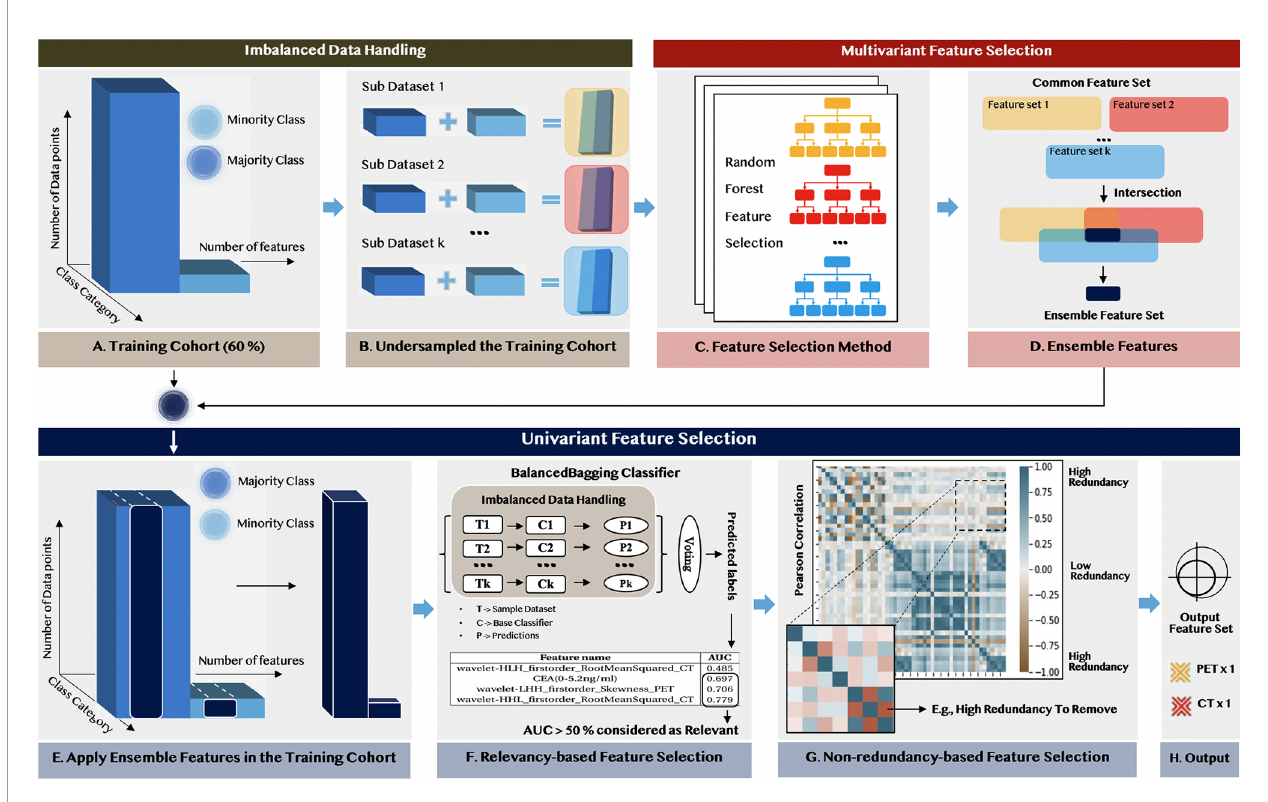
FIGURE 2 | The fl owchart of feature selection for selecting representative non-redundant and relevant features, as well as handling imbalanced